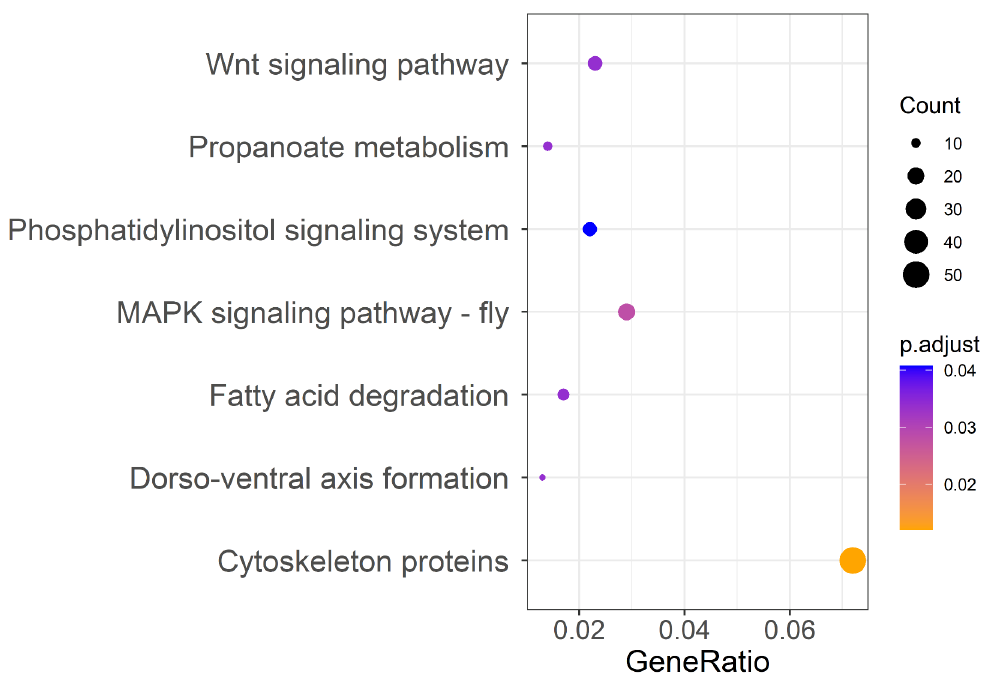
Figure 2. KEGG pathway annotation classification of genes located in F ST > 0.50 region of the Plutella xylostella genome of strains differing in susceptibility to chlorantraniliprole. The ordinate left is the KEGG classification, and the abscissa is the ratio of gene enrichment in the pathway. The size of the round spot represents the number of genes enriched in the pathway, and the color represents the size of the P adjust value.